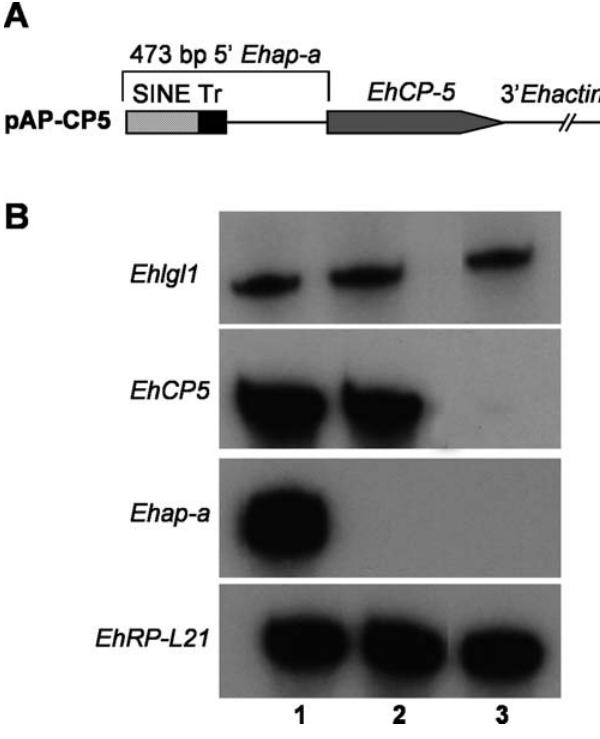
Figure 4. Induction of Capping of the Gal/GalNAc-Lectin to the Uroid Region of the Trophozoites Confocal microscopy of trophozoites; left photomicrographs, tropho- zoites incubated at 4 8 C; right photomicrographs, trophozoites were incubated at 37 8 C for 20 min to observe the induction of capping using two monoclonal antibodies against the heavy subunit of the Gal-lectin [35]. Each image shows the fluorescent Gal-lectin superimposed on a Nomarsky section. Samples are HM-1:IMSS, G3, and RBV (the plasmidless strain silenced in Ehlgl1 and Ehap-a ). DOI: 10.1371/journal.ppat.0020048.g004